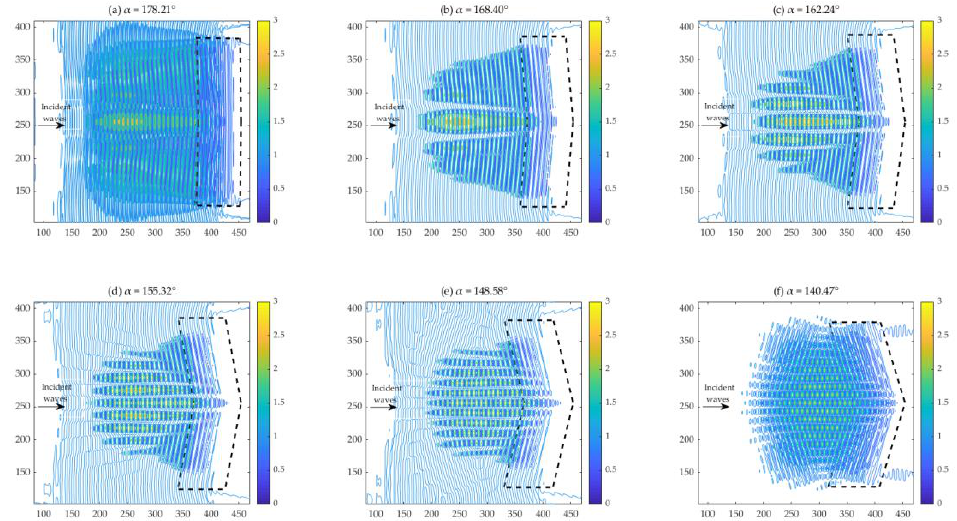
Figure 4. The values of A max / A 0 in the scenarios of regular waves under different angles α of V-shaped undulating bottom (The dashed outline refers to the V-shaped undulating bottom range).